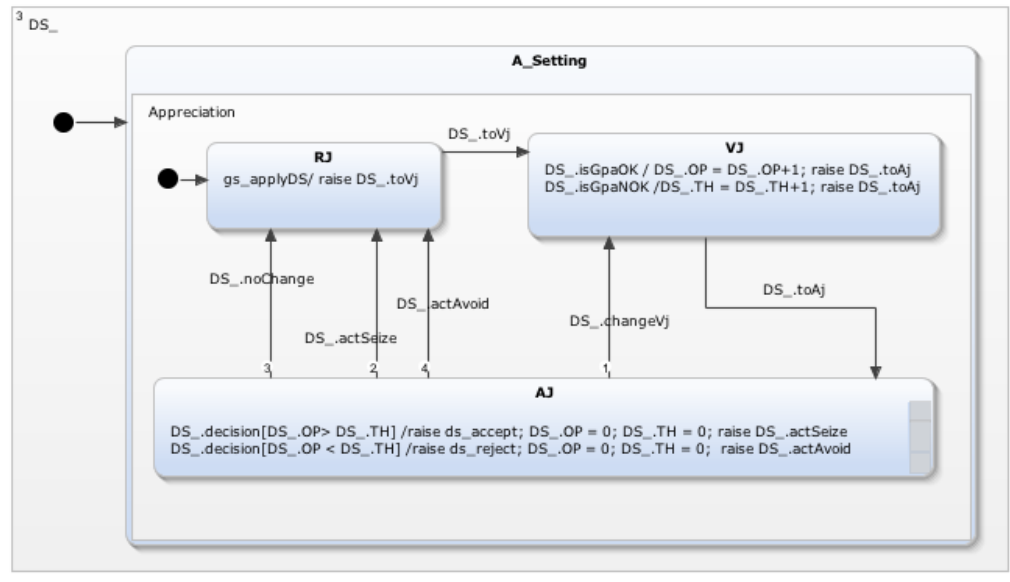
Figure 9. DS_ – the Appreciation statechart for the